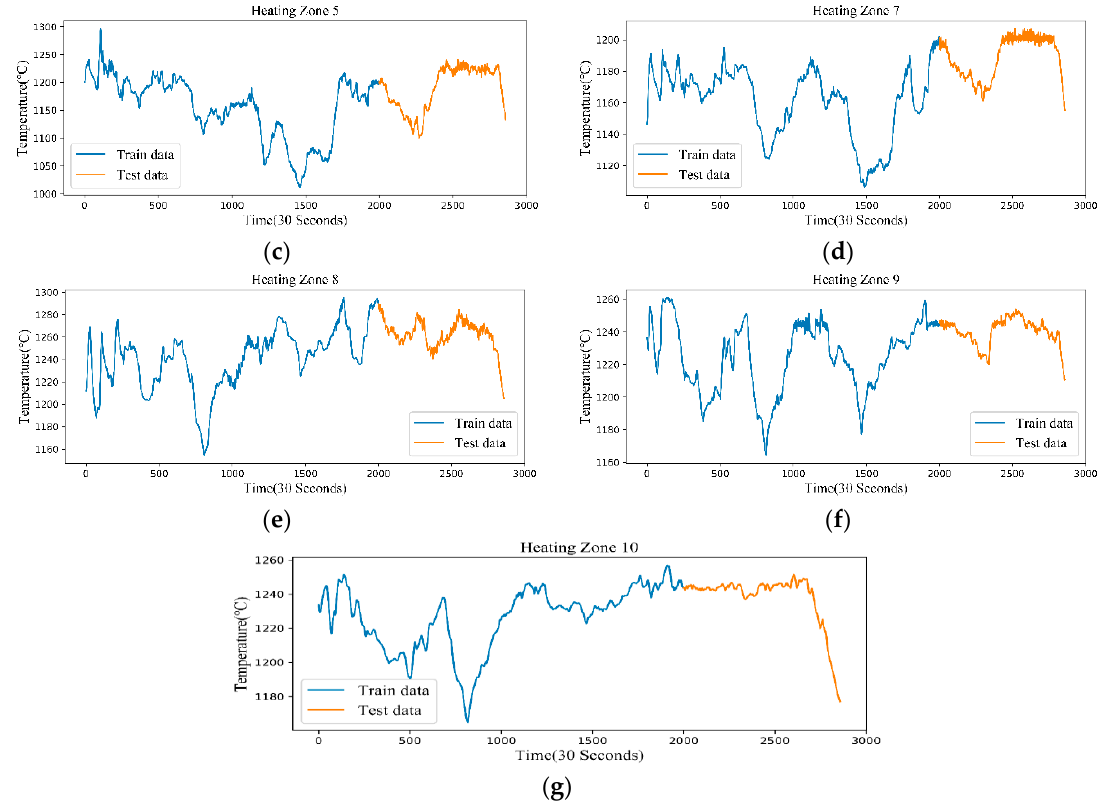
Figure A1. Temperature distribution of target variables in each heating zone except those mentioned in the manuscript, ( a – g ) shows the temperature distribution of heating zone 3–10 except heating zone 6. Table A1. Requirements for temperature control of cold slab furnace.